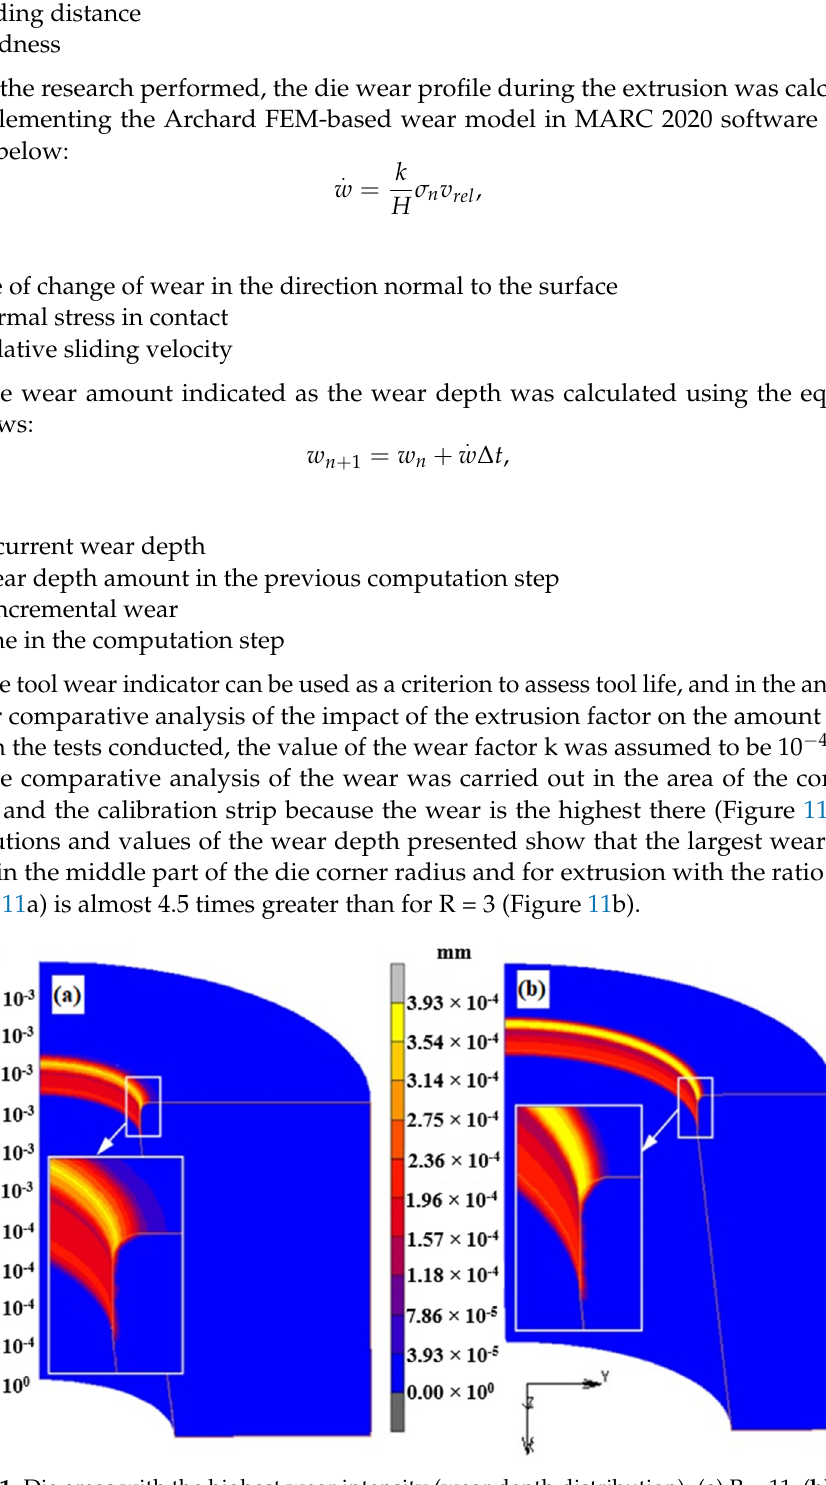
Figure 11. Die areas with the highest wear intensity (wear depth distribution): ( a ) R = 11, ( b ) R = 3.